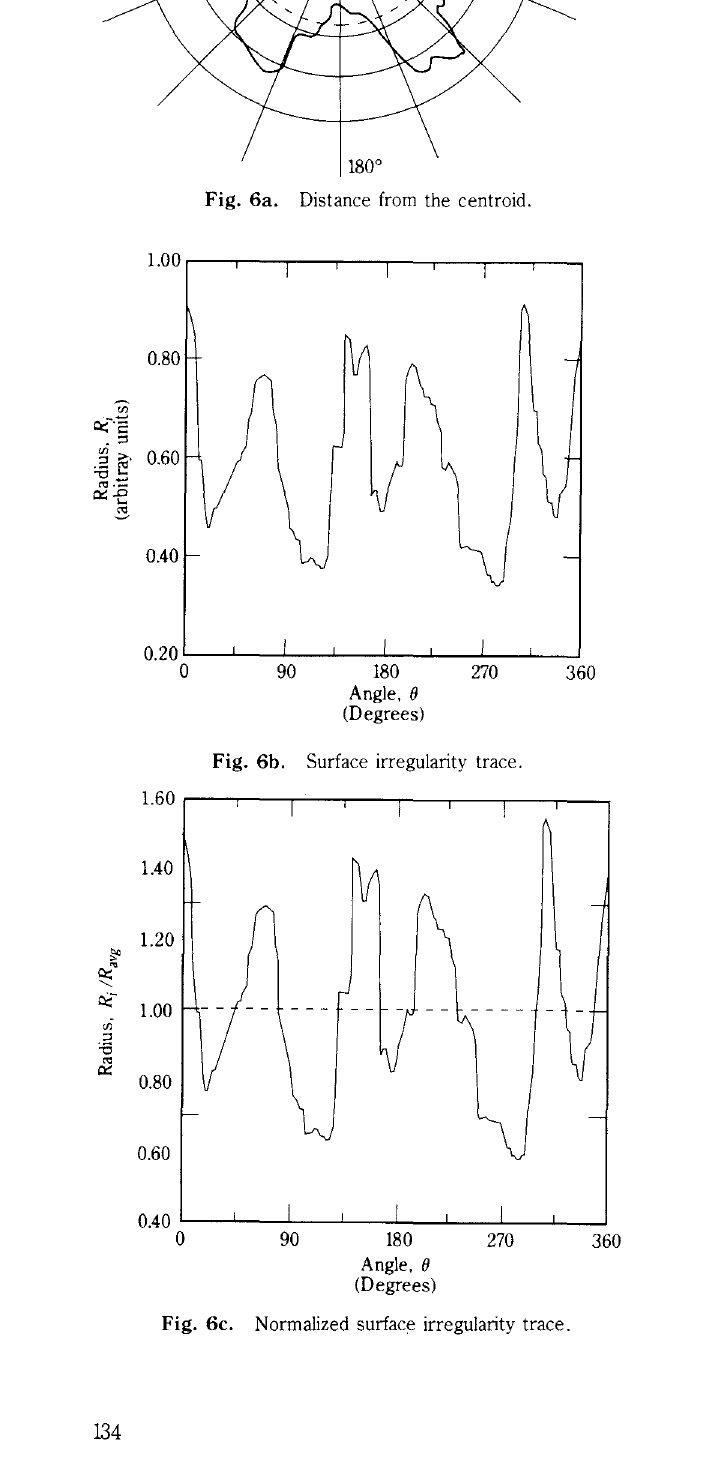
Fig. 6d. Normalized trace after noise